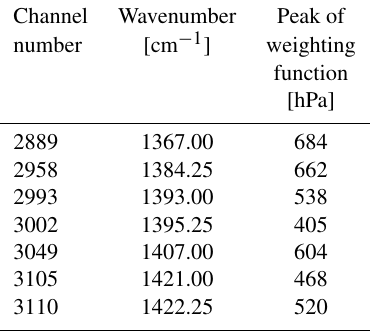
Table 1. Details of the seven IASI mid- and upper-tropospheric wa- ter vapour channels assimilated at